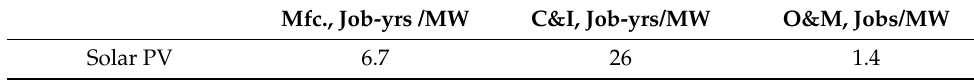
Table 2. Main factors for rooftop solar PV installations [31].